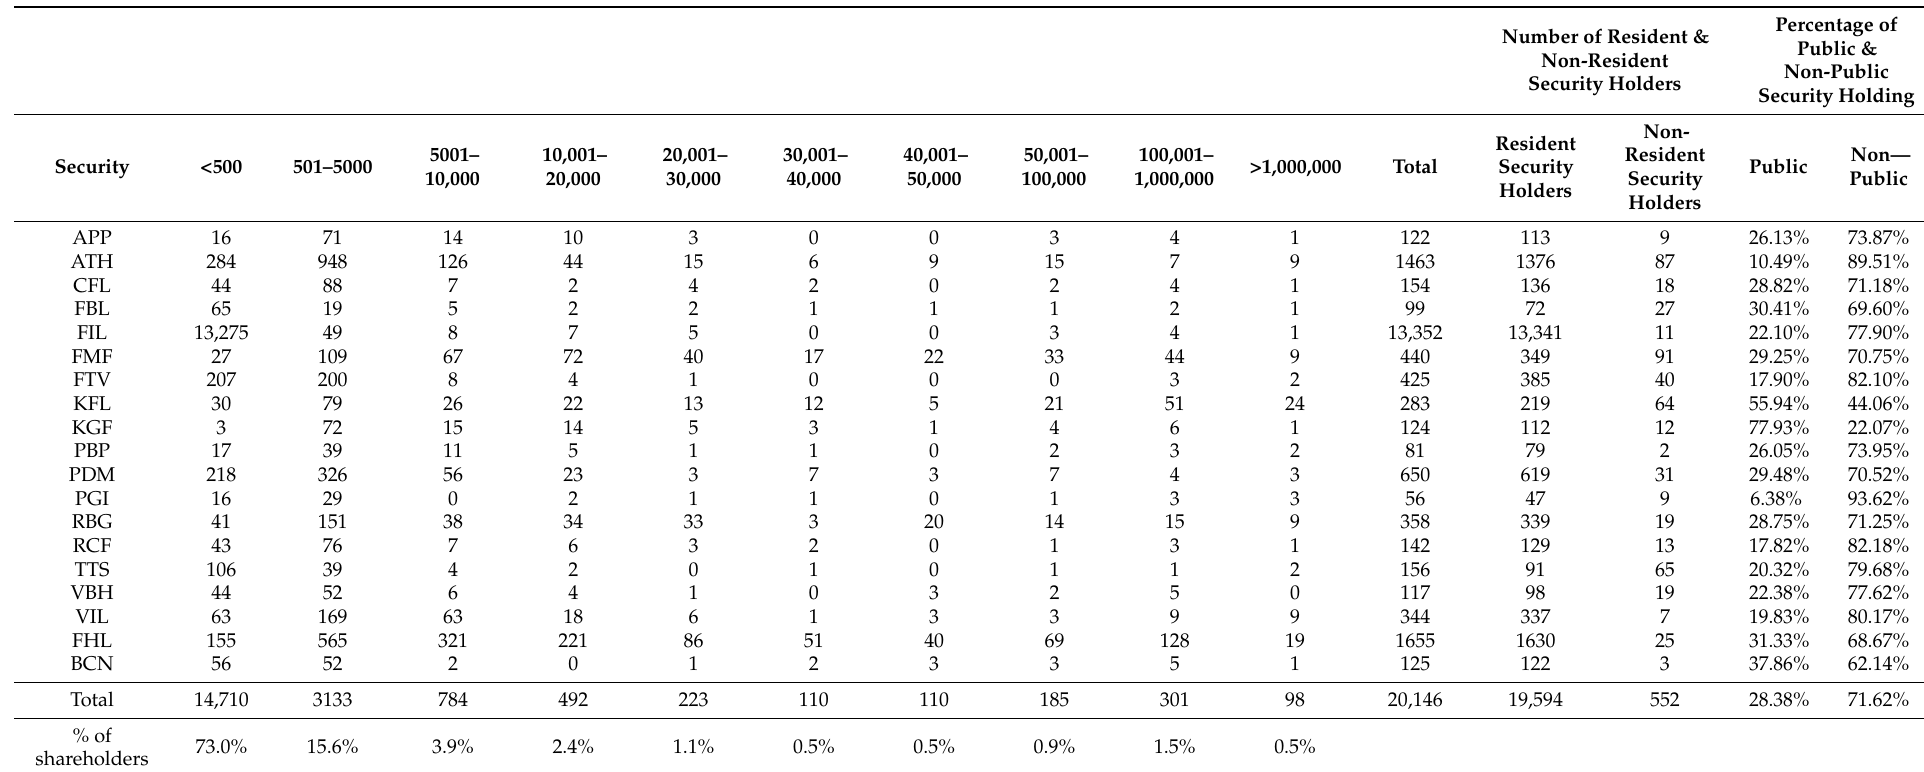
Table 3. Distribution of Security Holding and Number of Security